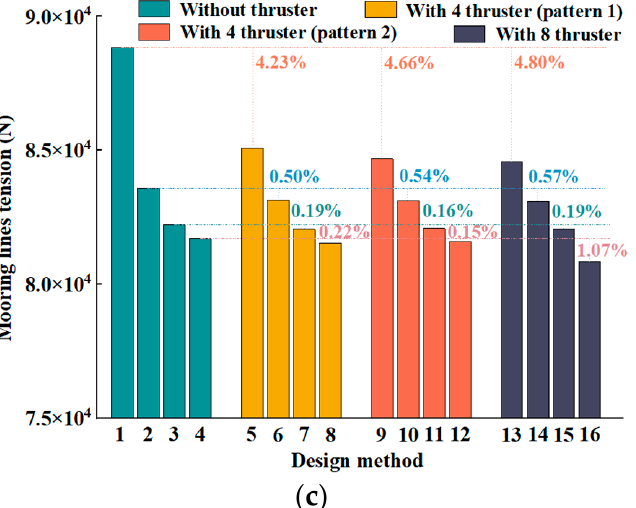
Figure 9. Tension of the mooring lines under different environmental loads and positioning modes. ( a ) Wave condition; ( b ) Level ice condition; ( c ) Ice floes condition.